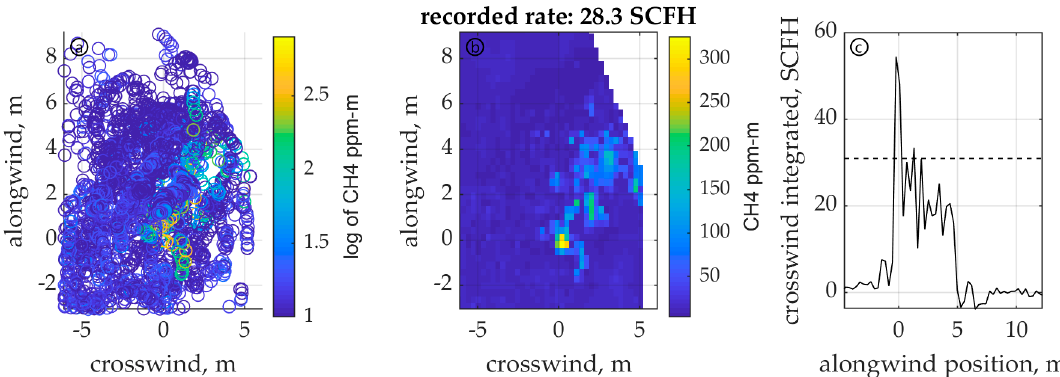
Figure 6. Crosswind-integration rate method: ( a ) individual measurements after rotation; ( b ) gridded interpolation of a; and ( c ) crosswind integrated flux. The horizontal dashed line in ( c ) indicates the estimated leak rate.